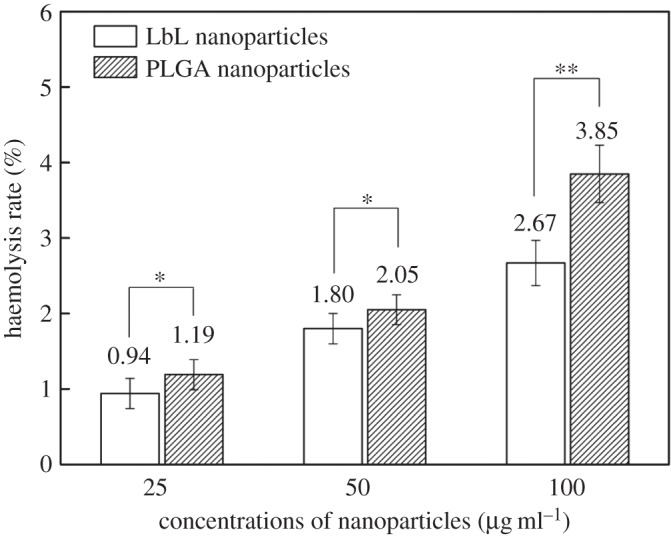
Haemolysis test.